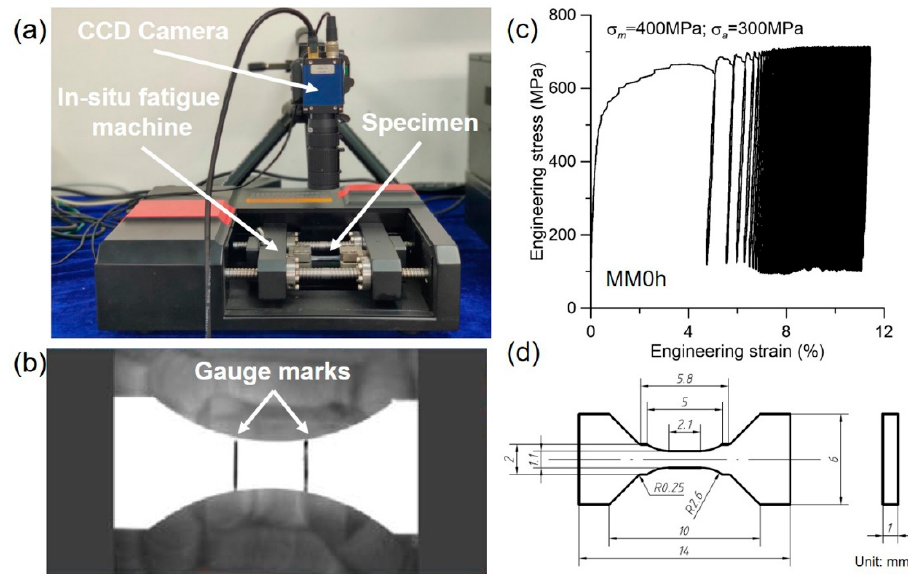
Figure 3. ( a ) Experiment setup; ( b ) typical stress-strain response; ( c ) displacement of gauge area measurement; ( d ) dimensions of specimen for ratcheting-fatigue test.